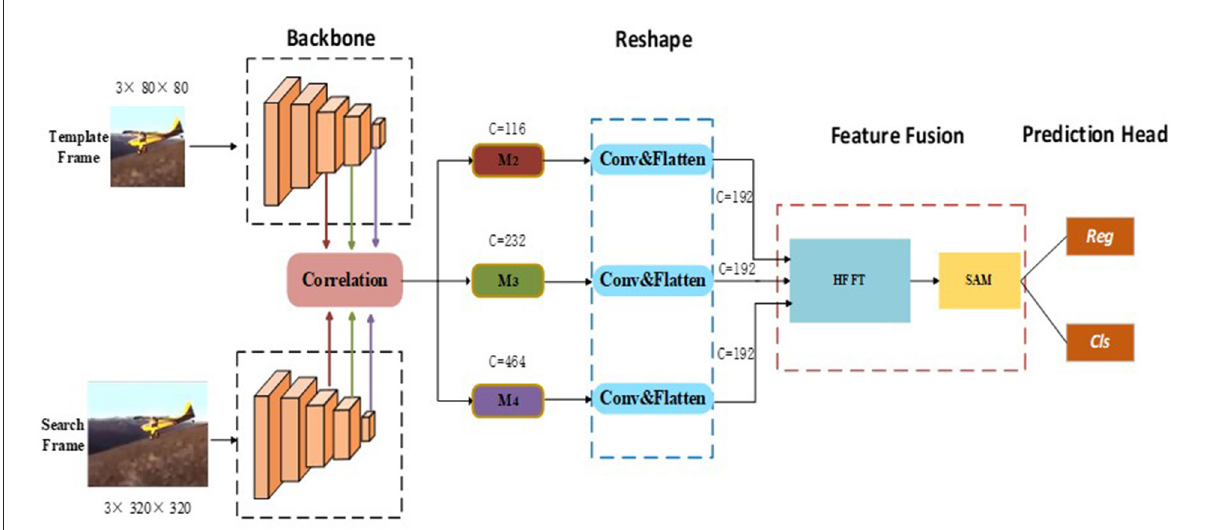
FIGURE1 Architecture of the proposed SiamHFFT tracking framework. This framework contains four fundamental components: a feature extraction network, reshaping module, feature fusion module, and prediction head. The backbone network is used to extract hierarchical features. The reshaping module is designed to perform convolution operations and flatten features. The feature fusion transformer consists of the proposed HFFT module and a self-attention module (SAM). Finally, bounding boxes are estimated based on the regression and classification